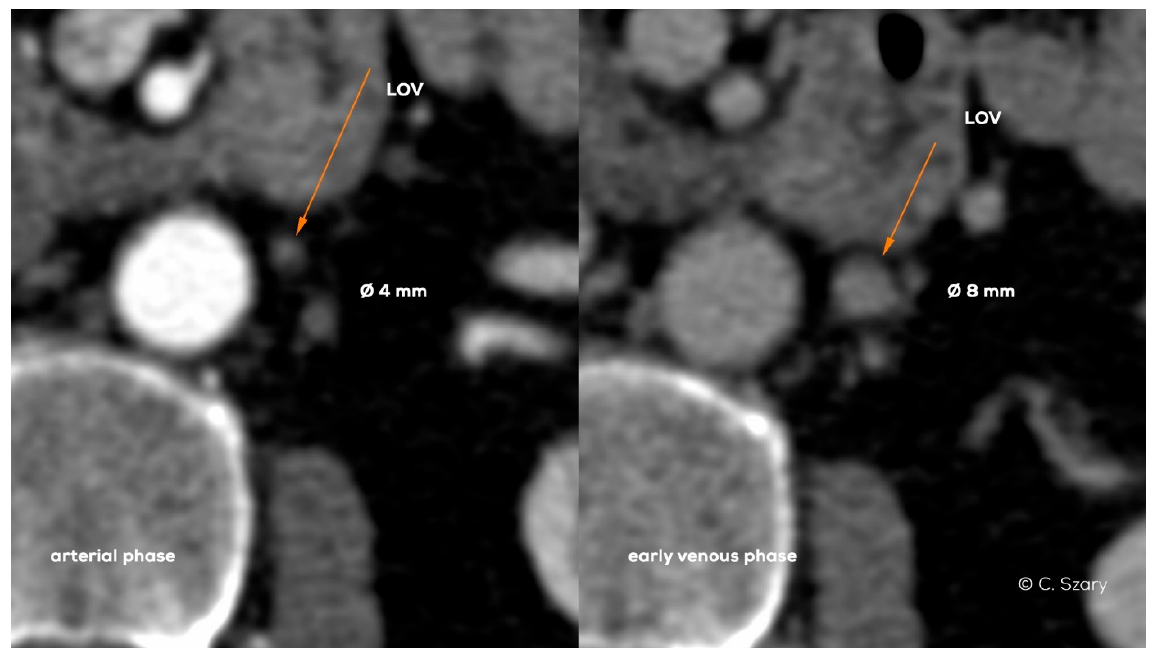
Figure 19. Axial CT images in arterial and early venous phase show significant difference in left ovarian vein (LOV) diameters.